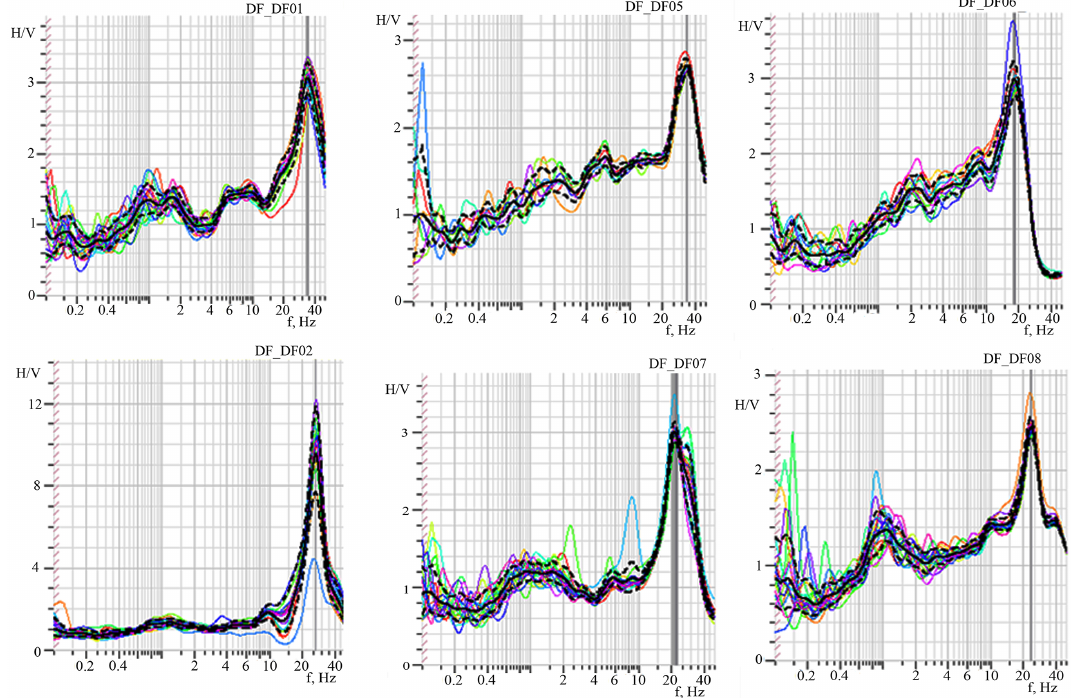
Figure 9. Results of horizontal-to-vertical (H/V) analysis for selected stations of the DAFNE array. The resonance frequency is marked by the grey bar, with width corresponding to error